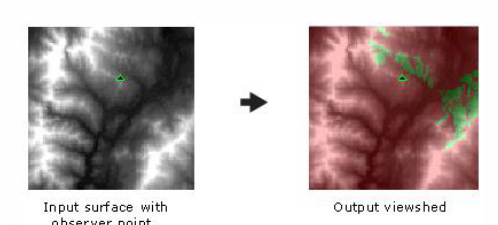
Figure 2 . Application of the ArcGIS viewshed analysis tool, with the visible range in green. (Esri, 2020)